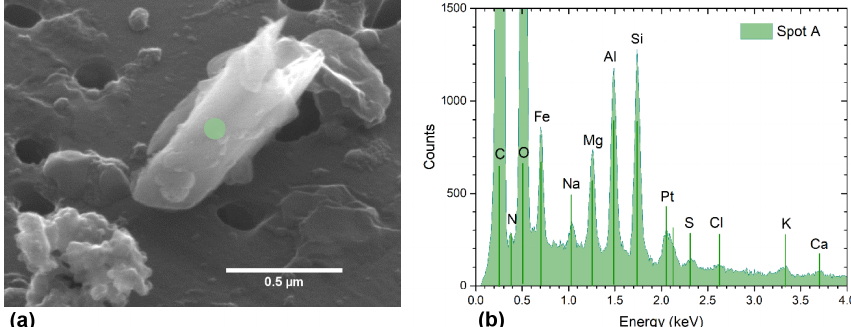
Figure 11. Same as Fig. 4 but for a mineral dust particle. The EDX spectrum of the particle identifies chemical patterns that are characteristic for mineral dust (Al, Si, Mg, Fe, K, Ca), biogenic (N, Na, Cl, S), and carbonaceous (C, O)